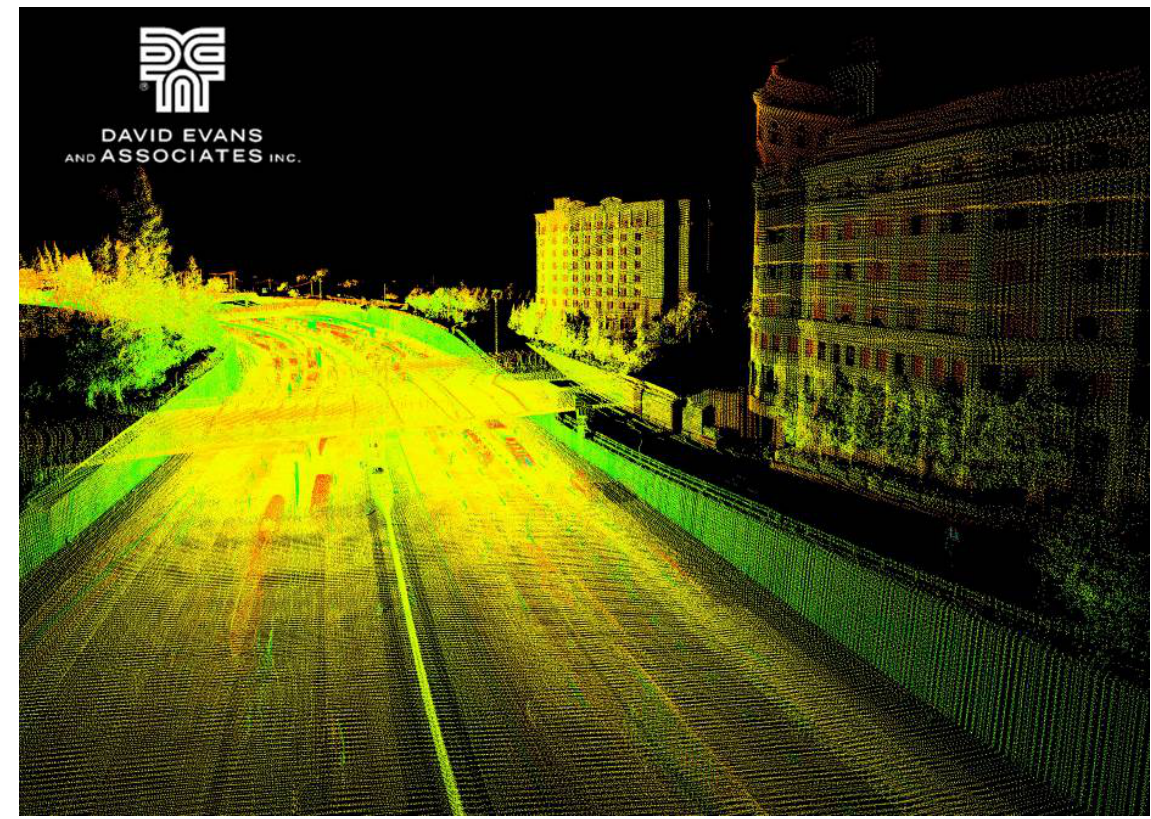
Figure 10. Mobile LIDAR data of a section of the I-5 corridor in Sacramento, CA (Courtesy of